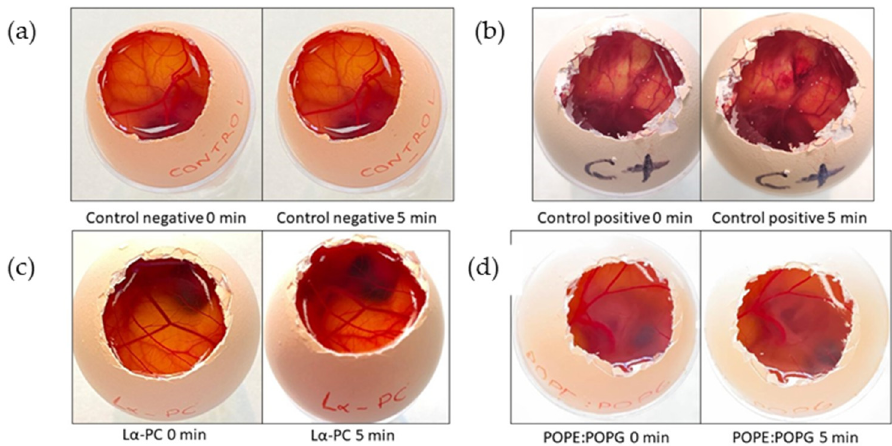
Figure 10. Evaluation of the irritant effect of the formulations by HET-CAM. ( a ) negative control (saline solution), ( b ) positive control (sodium hydroxide solution 0.1 N, ( c ) L α -PC liposome (L- α -phosphatidylcholine), and ( d ) POPE:POPG liposome (1-palmitoyl-2-oleoyl- phosphatidylethanolamine: 1-Palmitoyl-2-oleoyl-sn-glycerol-3-phosphoglycerol (3:1, mol/mol). The values of the IS obtained after the HET-CAM test are reported in Table 7. IS values obtained for both liposomes were below 0.9, indicating that the liposomes did not show any irritating